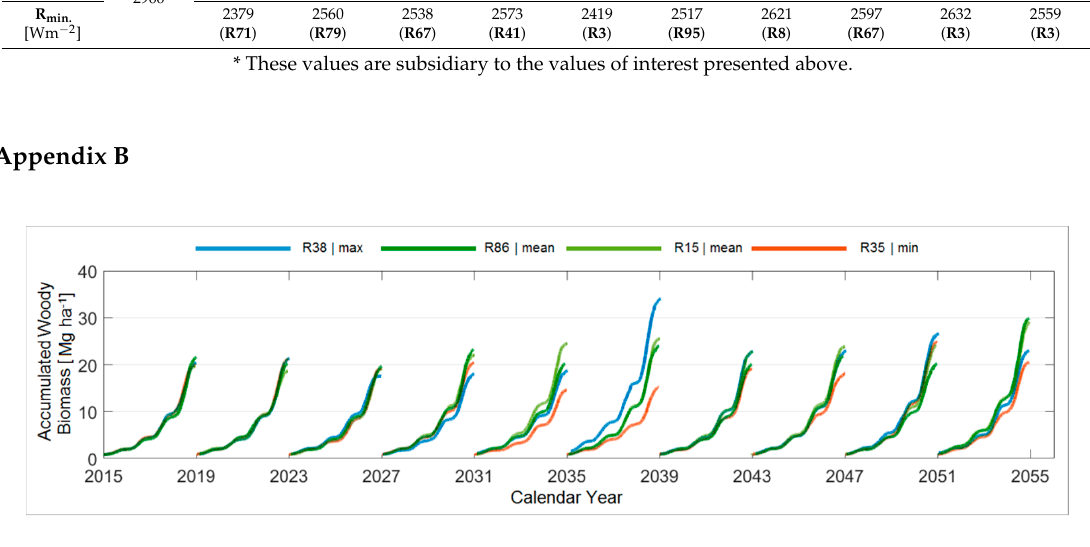
Figure A3. Walter-Lieth climate diagrams for realisation 79 in terms of average annual air temperature, precipitation and global radiation, according to the established periods and with respect to the vegetation period and accumulated woody biomass for both tree species.